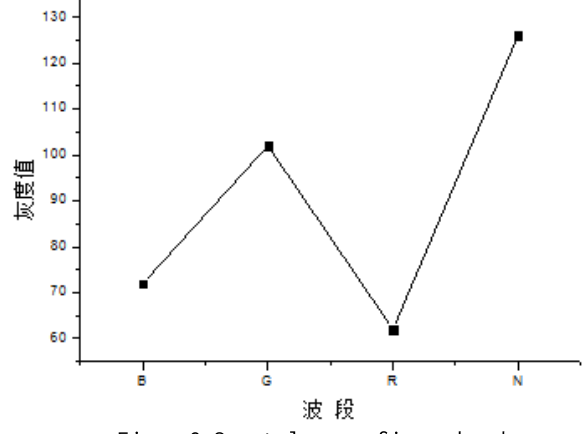
Figure 6. Spectral curve of image